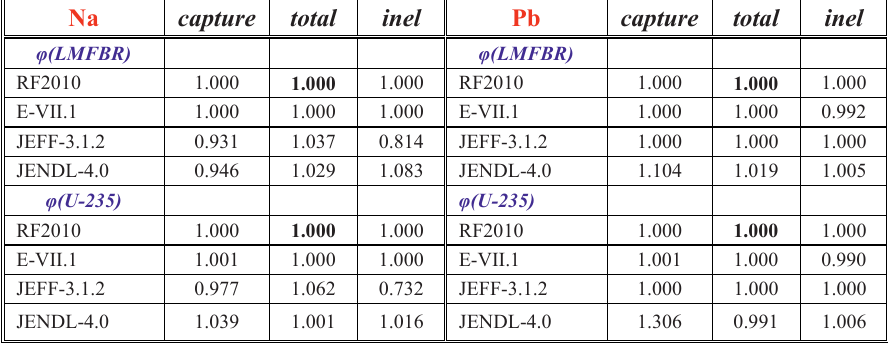
Table 1. The comparison of the average cross sections for coolant